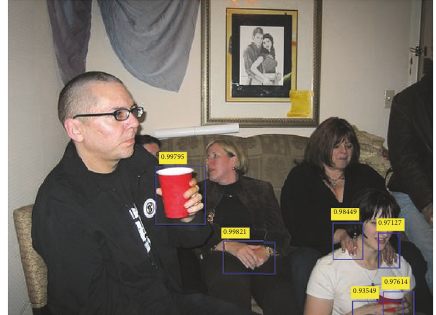
Figure 1: An example of the our hand detection scheme. Despite large occlusion and various scales of hands interacting with objects or other hands, the hands can be detected